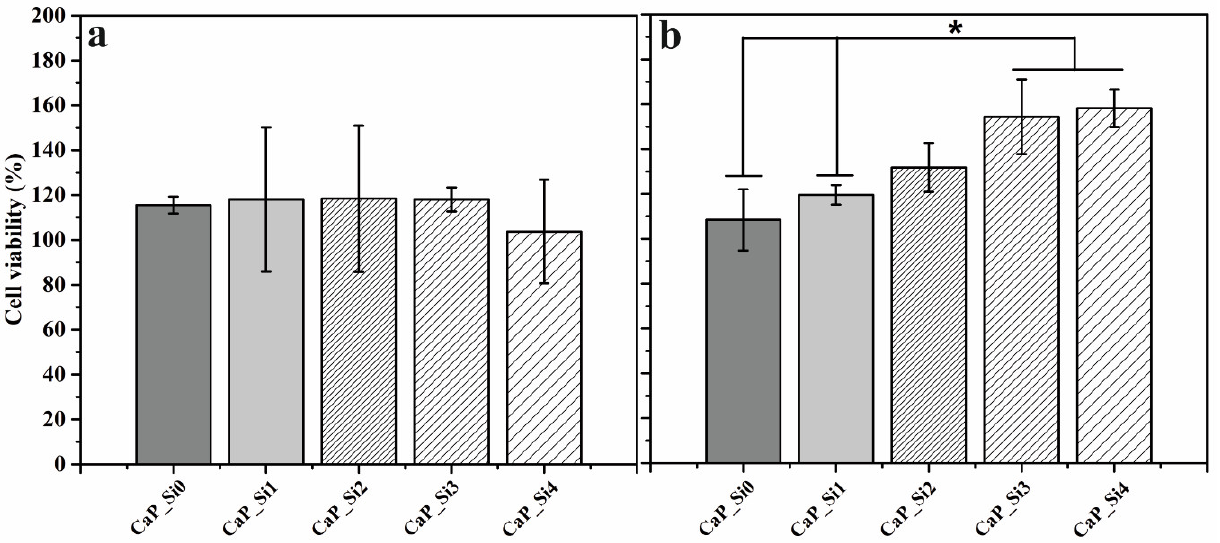
Figure 9. Cell viability (%) after ( a ) 1 and ( b ) 3 days of incubation with DMEM extracts of calcium phosphate powders determined by MTT assay. The significant difference between the two groups (*): p <